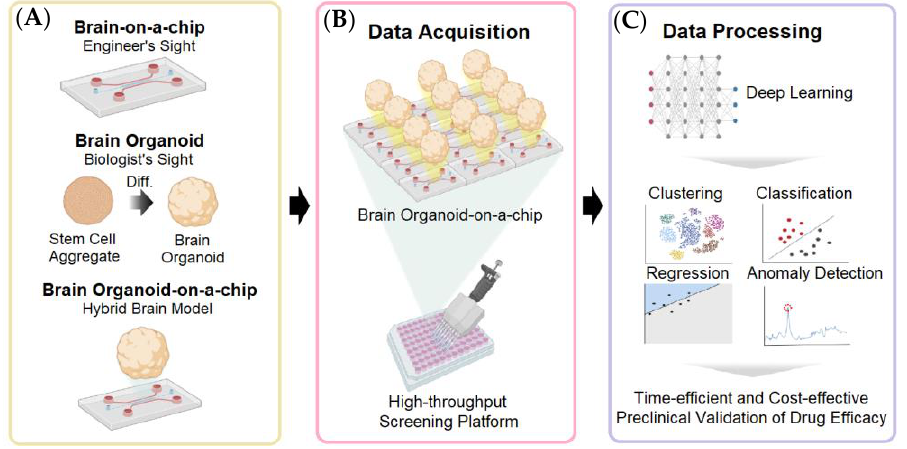
Figure 11. Comparison of human brain avatars and the deep learning techniques for high-throughput drug screening [104]. ( A ) The relationship between different brain avatars. ( B ) The injection-molded microfluidic chip allows the high-throughput drug screening of brain organoids-on-a-chip. ( C ) Deep learning is needed to conduct biological data analysis on massive data for high-throughput drug screening. Reproduced with permission from AIP Publishing Copyright (2023).